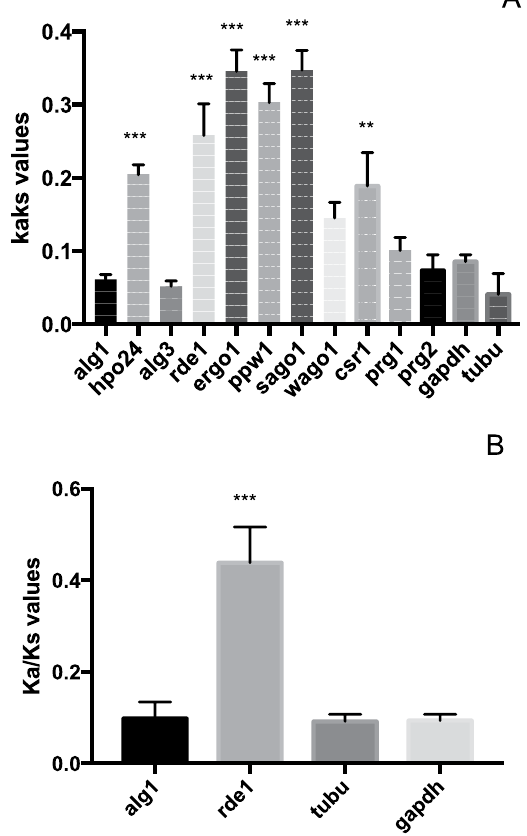
Figure 5. Figure 5A: Evolutionary rate of argonaute transcript sequences within the Caenorhabditis genus. Ka/Ks values are estimated by means of ML-tree based comparison and by using sequence information of C. elegans , C. briggsae , C. remanei and C. brenneri . Figure 5B: The evolutionary rate for Argonaute proteins in nematodes, determined by estimating the Ka/Ks values by means of ML-tree based comparison and by using sequence information of C. elegans , Ascaris suum, Brugia malayi and Necator americanus . Due to the enormous complexity and variation in the Argonaute AGO family present in nematodes, we could only find orthologs of the miRNA-class AGO alg1 and the siRNA-class AGO rde1 in all studied nematode species. The bars represent the mean + / − SEM of individual Ka/Ks values per gene. Statistics (MWU-test) support difference with the housekeeping genes glyceraldehyde 3-phosphate dehydrogenase (gapdh) and apha-tubulin1a (tubu); ** p < 0.01, *** p <